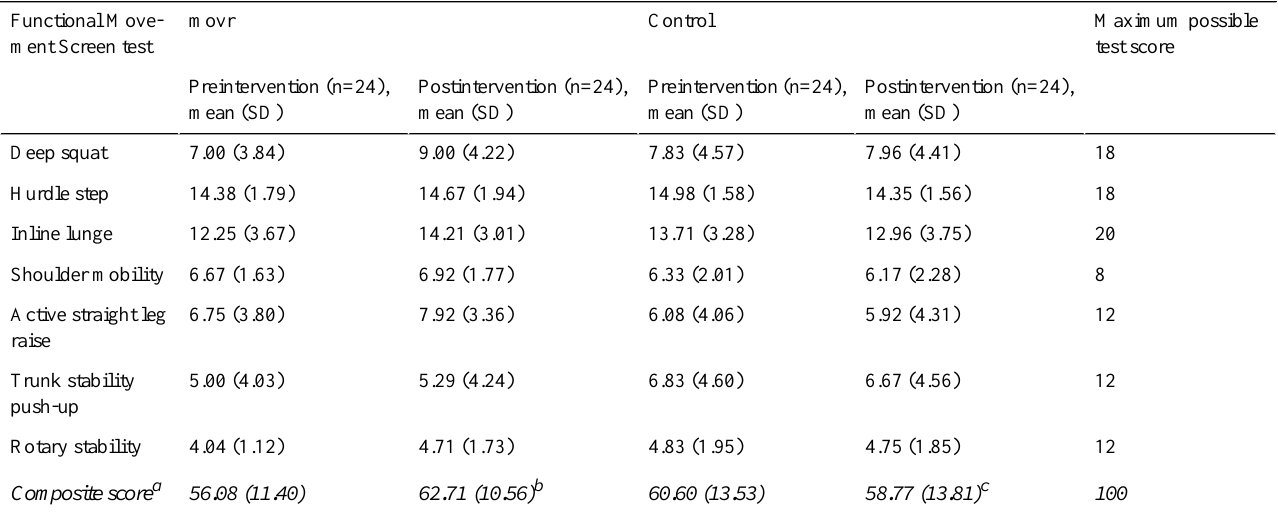
Table 2. Mean values for the 100-point Functional Movement Screen scores pre- and postintervention. scoreControlmovrFunctional Move- ment Screen